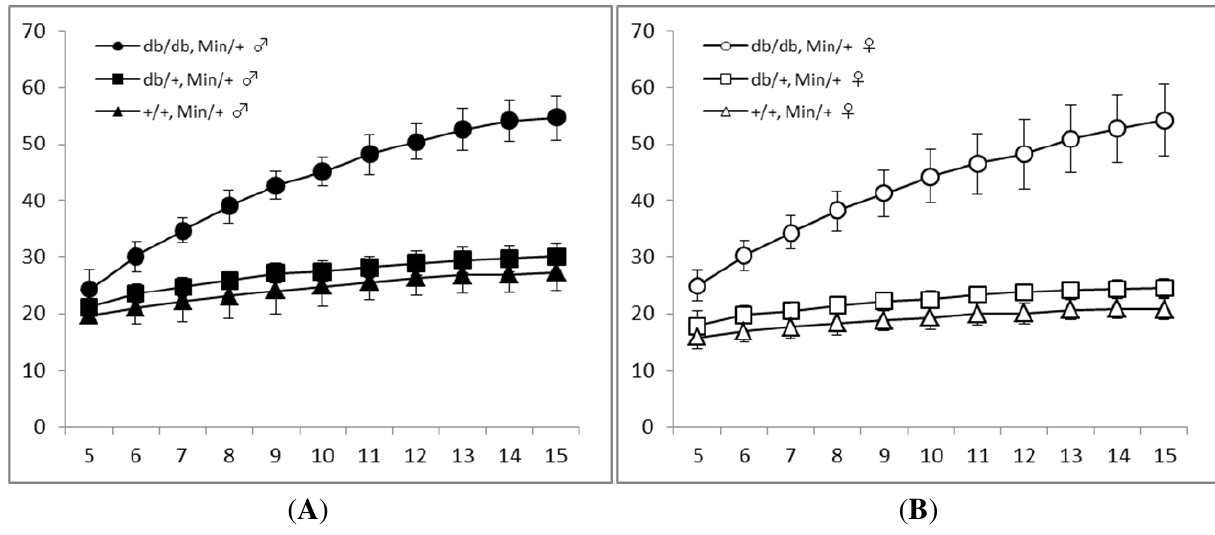
Figure 1. Body weight gains during the study: ( A ) males and ( B ) females.